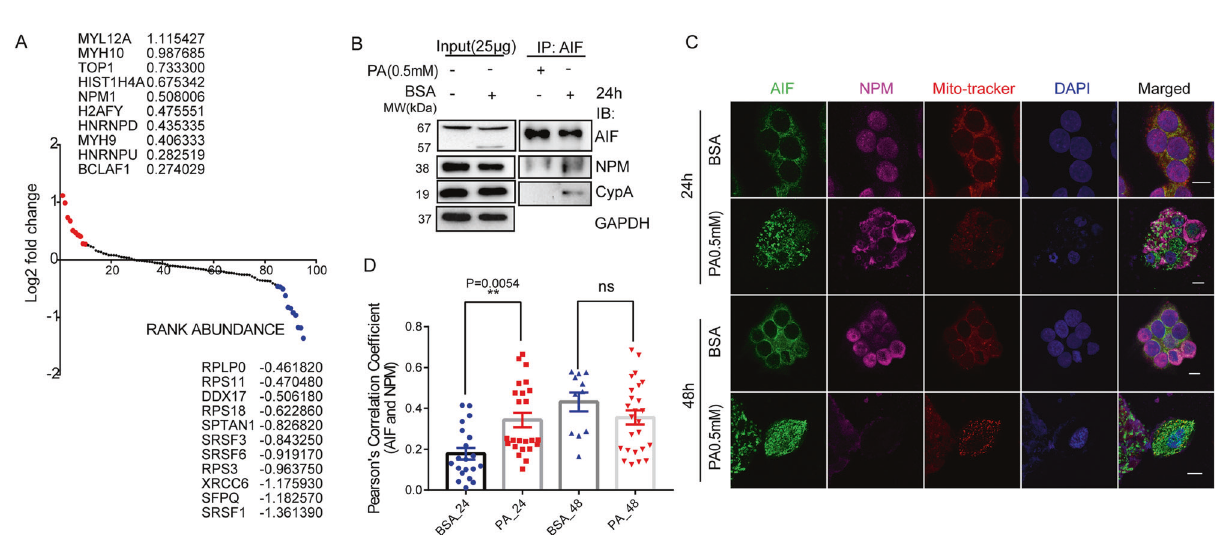
Fig. 9 AIFM1/NPM1axis operates during PA-induced cell death. Identi fi cation of potent AIFM1 interacts upon PA stimulation. Scatter diagram showing the AIFM1-interacting proteins in HepG2 after treatment with control vehicle or PA (0.5 mM). The y axis shows the Log2 fold change (PA/BSA) and the x axis shows protein rank abundance. Each point represents a protein. Red dots denote the top 10 highly interacting, and blue indicates poorly interacting partners of AIFM1 in both BSA and PA-treated conditions ( A ). The endogenous interactions between AIF and NPM were determined by co-immunoprecipitation (Co-IP) assay in PA (0.5 mM) treated HepG2 cells at 24 h. Blots were developed against AIF, NPM, and CypA. GAPDH was used as an internal control for input ( B ). The cellular distribution of NPM1 upon PA stimulation. Immuno fl uorescence analysis demonstrated NPM (pink) translocation from the nucleus to mitochondria (red) where cells were close to death, followed by AIF (green) translocated to the nucleus (blue) in treated (0.5 mM PA) condition. The localization dynamics were observed at two different time points (24 h and 48 h). The Pearson coef fi cient has been measured for the colocalization of AIF with DAPI and NPM with MITO TRACKER. The overlay channel for all merged conditions was shown on the right panel with a scale bar of 10 µm ( C ). Colocalization quanti fi cation was performed using Pearson ’ s value for AIF and NPM ( D ). Ordinary one-way ANOVA followed by Tukey ’ s multiple comparisons test was applied for statistical analysis. Error bars are showing mean ± SEM; n ≥ 3; * p < 0.05, ** p < 0.01, *** p < 0.001, **** p < 0.0001, and ns = non-signi fi